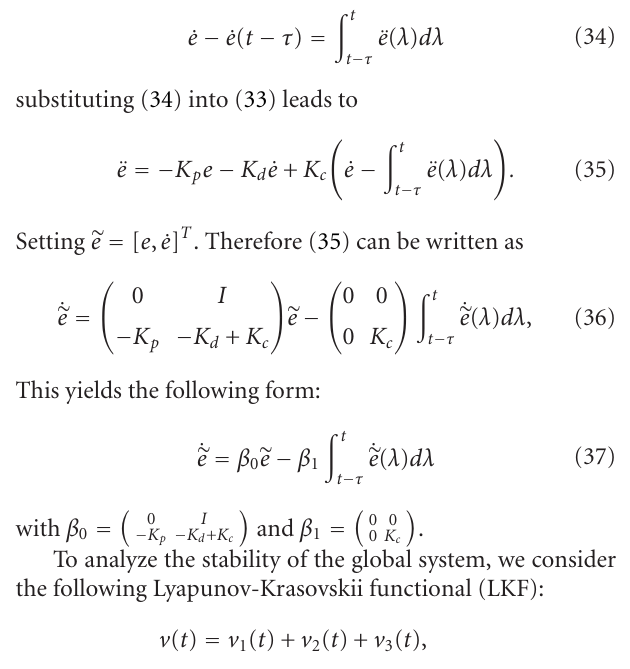
4.1. Stability Analysis. Substituting (29) into (1)